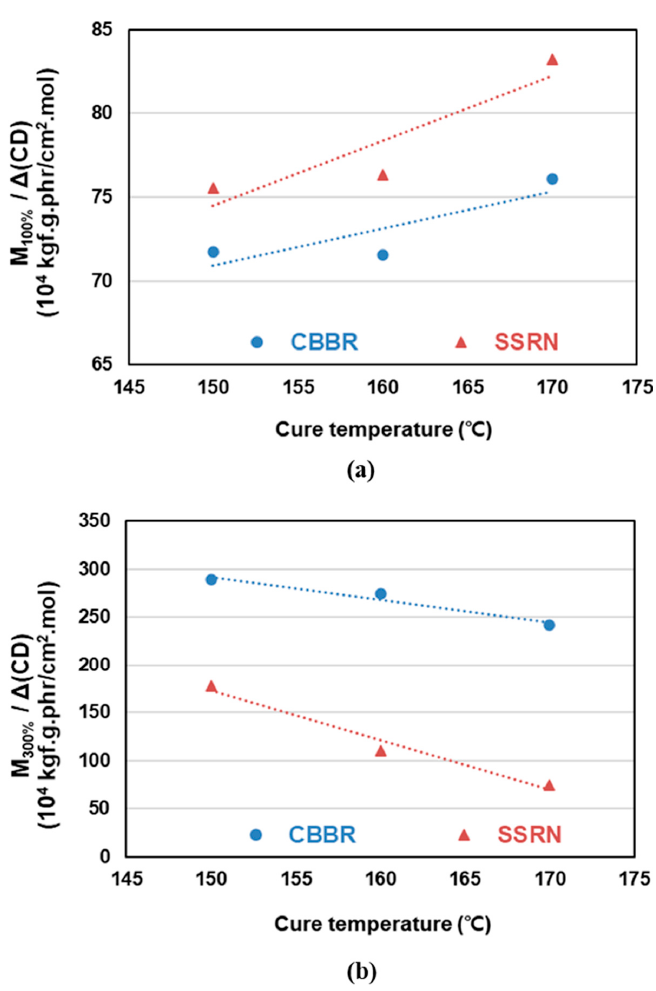
Figure 7. Change of the mechanical properties of the SBR binary filler compounds by different cure temperatures: ( a ) 100% modulus and ( b ) 300% modulus.